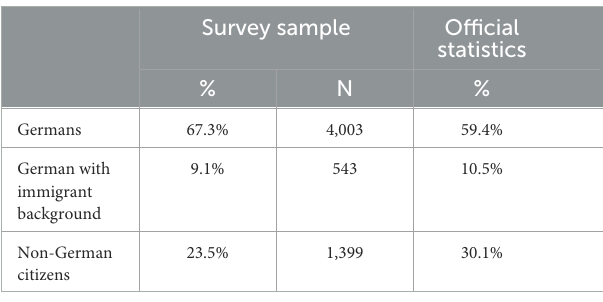
TABLE 1 Persons with immigrant background in survey sample and population of